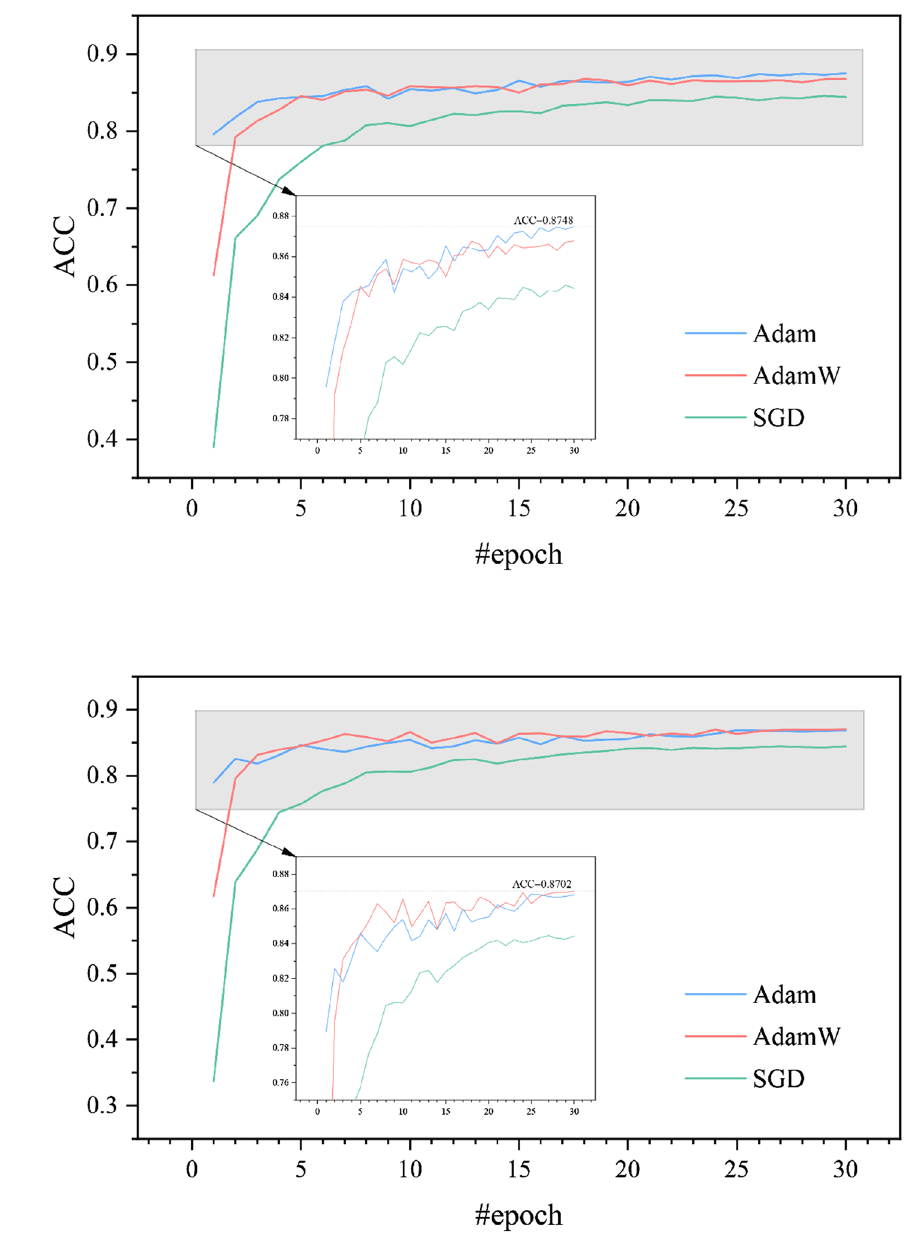
Fig. 9 Accuracy comparison of different optimizers with dropout rate=0.15